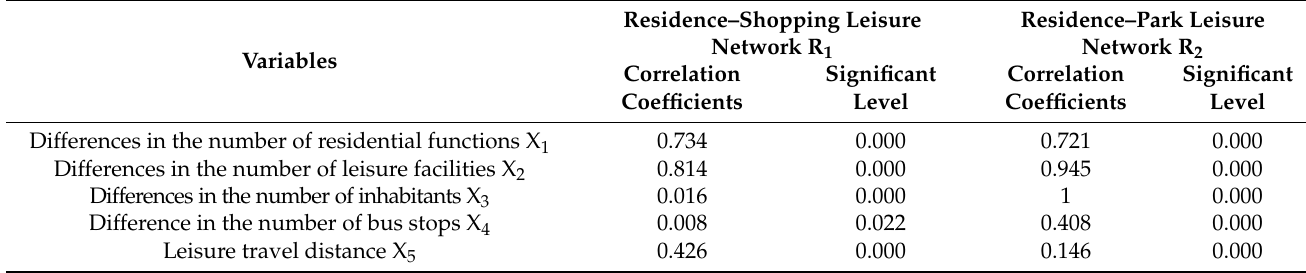
Table 3. Correlation between dependent variables and influencing factors QAP